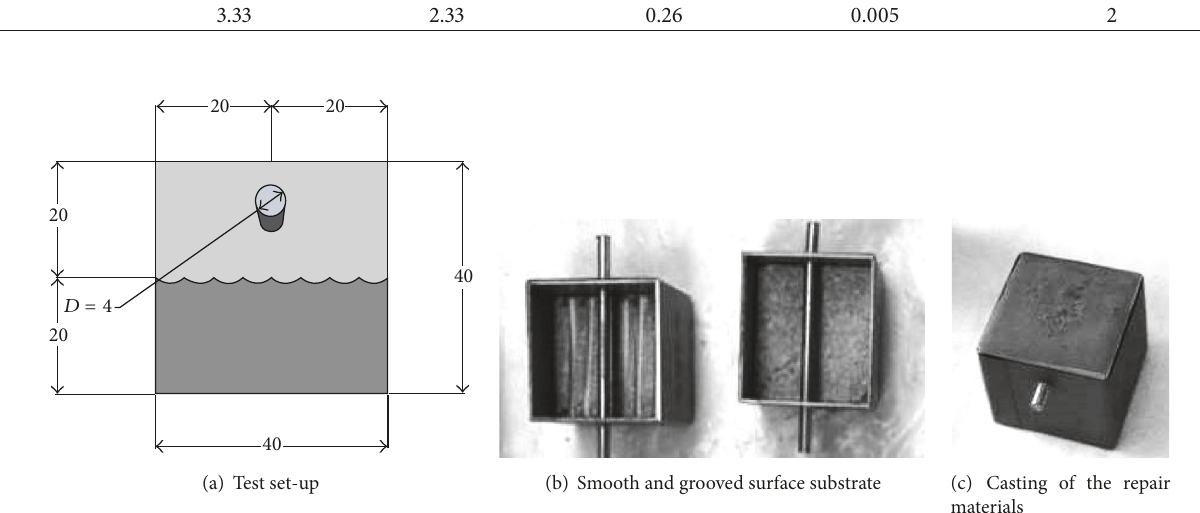
Figure 3: Preparation of the repair systems for accelerated corrosion tests.